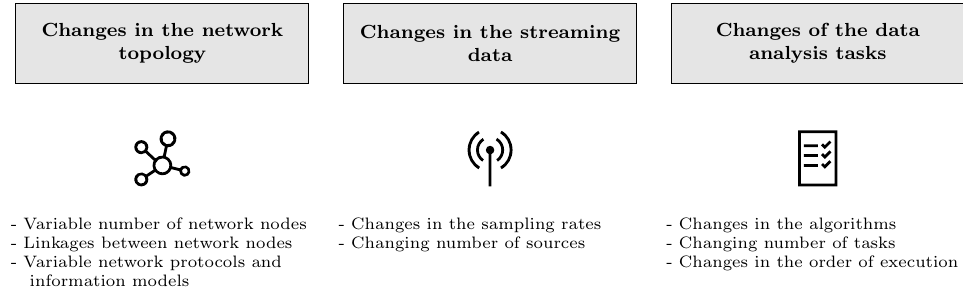
Figure 1. A systematic overview of the dynamic changes in IIoT